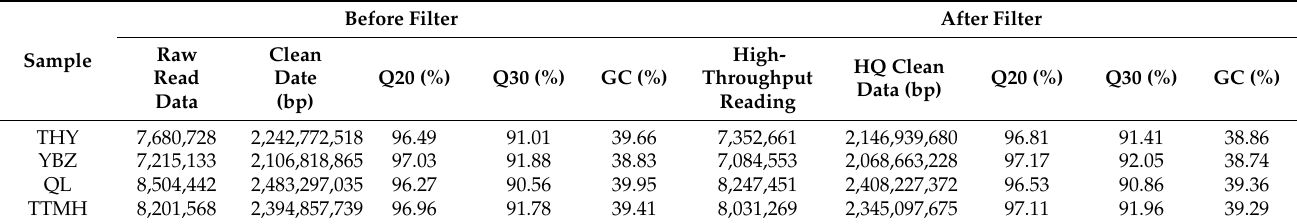
Table 1. Statistics of genomic sequences generated by RAD-seq.